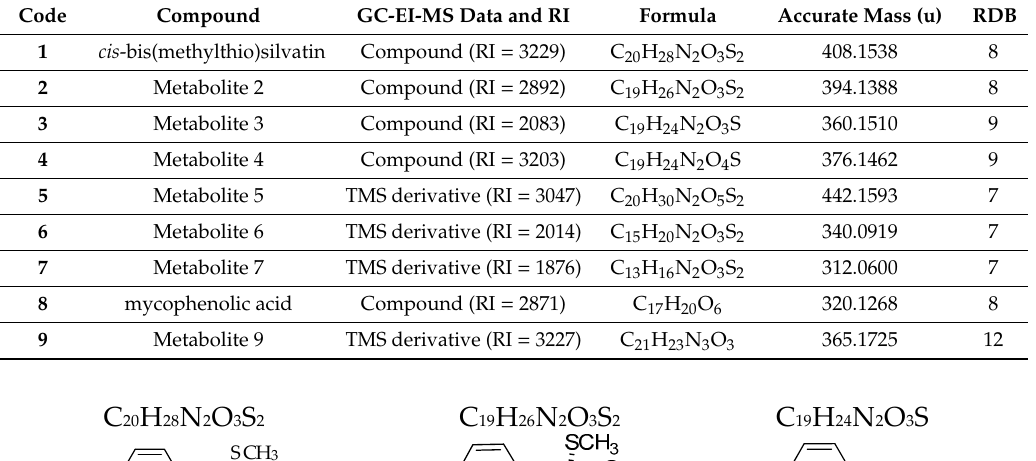
Table 1. Data concerning nine targeted metabolites of strain AN4 collected via GC-EI-MS and LC-MS ESI-HRMS. Uncertainty with regards to the reported values of the accurate mass is typically ± 0.0002–0.0005 u. RDB (Ring + Double Bonds) is calculated from empirical formulas by a standard algorithm [11].